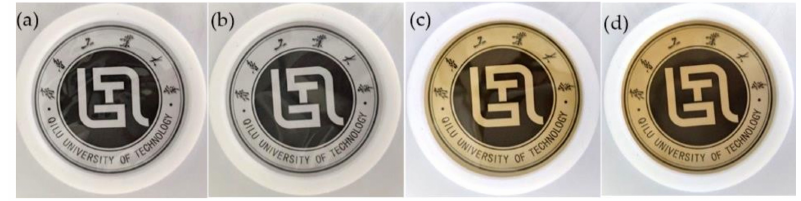
Figure 1. Photograph of ( a ) chitosan (CS), ( b ) CS-bentonite (CS-BT), ( c ) CS- hot water extract (HWE 10 ), and ( d ) CS-BT-HWE 10